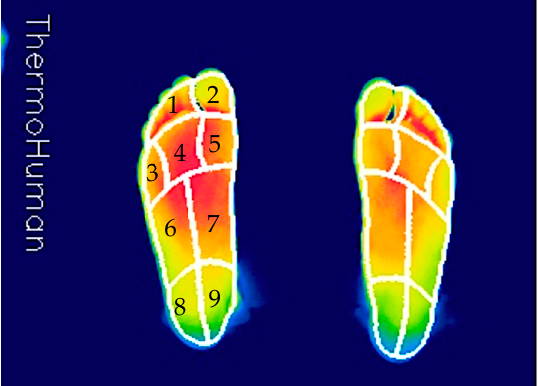
Figure 3. The 9 plantar regions of interest, automatically analyzed with ThermoHuman software.